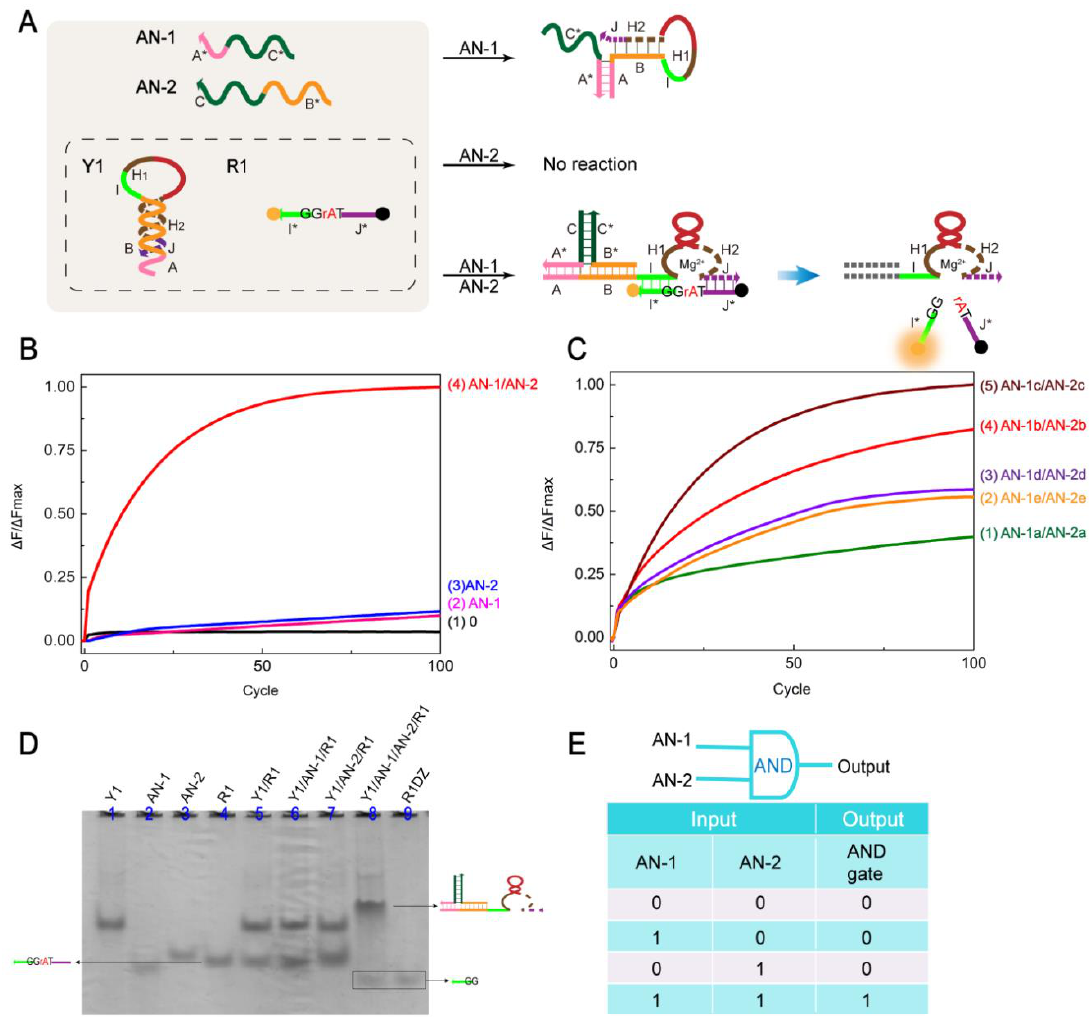
Figure 2. ( A ) Schematic of the AND logic gate. ( B ) Time-dependent normalized fluorescence intensity change (ΔF/ΔFMax) at different inputs. Curves 1–4 reflect the change in fluorescence of the AND gate at different inputs. The time interval is 3 min, 100 cycles. All data represent the average of three replicates. ( C ) Time-dependent normalized fluorescence intensity varies with input sequence differences (ΔF/ΔFMax). Curves 1–5 indicate that AN-1 and Y1 B domain have 0 bp (AN-1a), 1 bp (AN-1b), 2 bp (AN-1c), 3 bp (AN-1d), 4 bp (AN-1e) paired fluorescence changes. AN-2 varies with the change of AN-1. The time interval is 3 min, 100 cycles. All data represent the average of three replicates. ( D ) Gel analysis of the AND gate reaction using 12% PAGE. Lane 1: Y1; Lane 2: AN-1; Lane 3: AN-2; Lane 4: R1; Lane 5: Y1 and R1; Lane 6: Y1, AN-1 and R1; Lane 7: Y1, AN-2 and R1; Lane 8: Y1, AN-1, AN-2, and R1; Lane 9: R1DZ. ( E ) AND gate logic symbol and truth table.